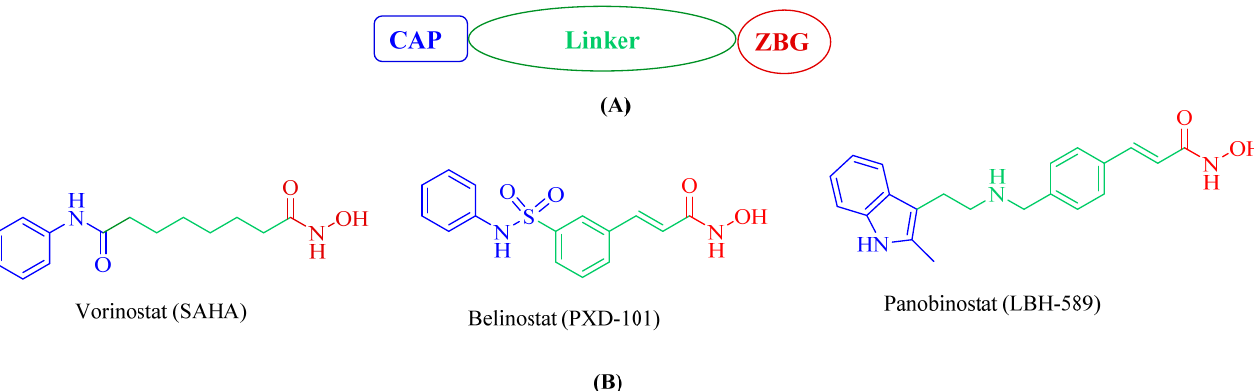
Figure 1. ( A ) Basic pharmacophore features of HDACIs; ( B ) FDA approved HDACIs.